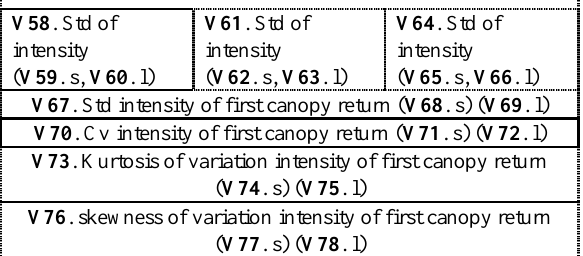
Figure 1. (a), (b) and (c) show a sample LiDAR pine, poplar and maple respectively. (d), (e) and (f) show the frequency distribution of first return, single return, last return and all return for pine, poplar and maple